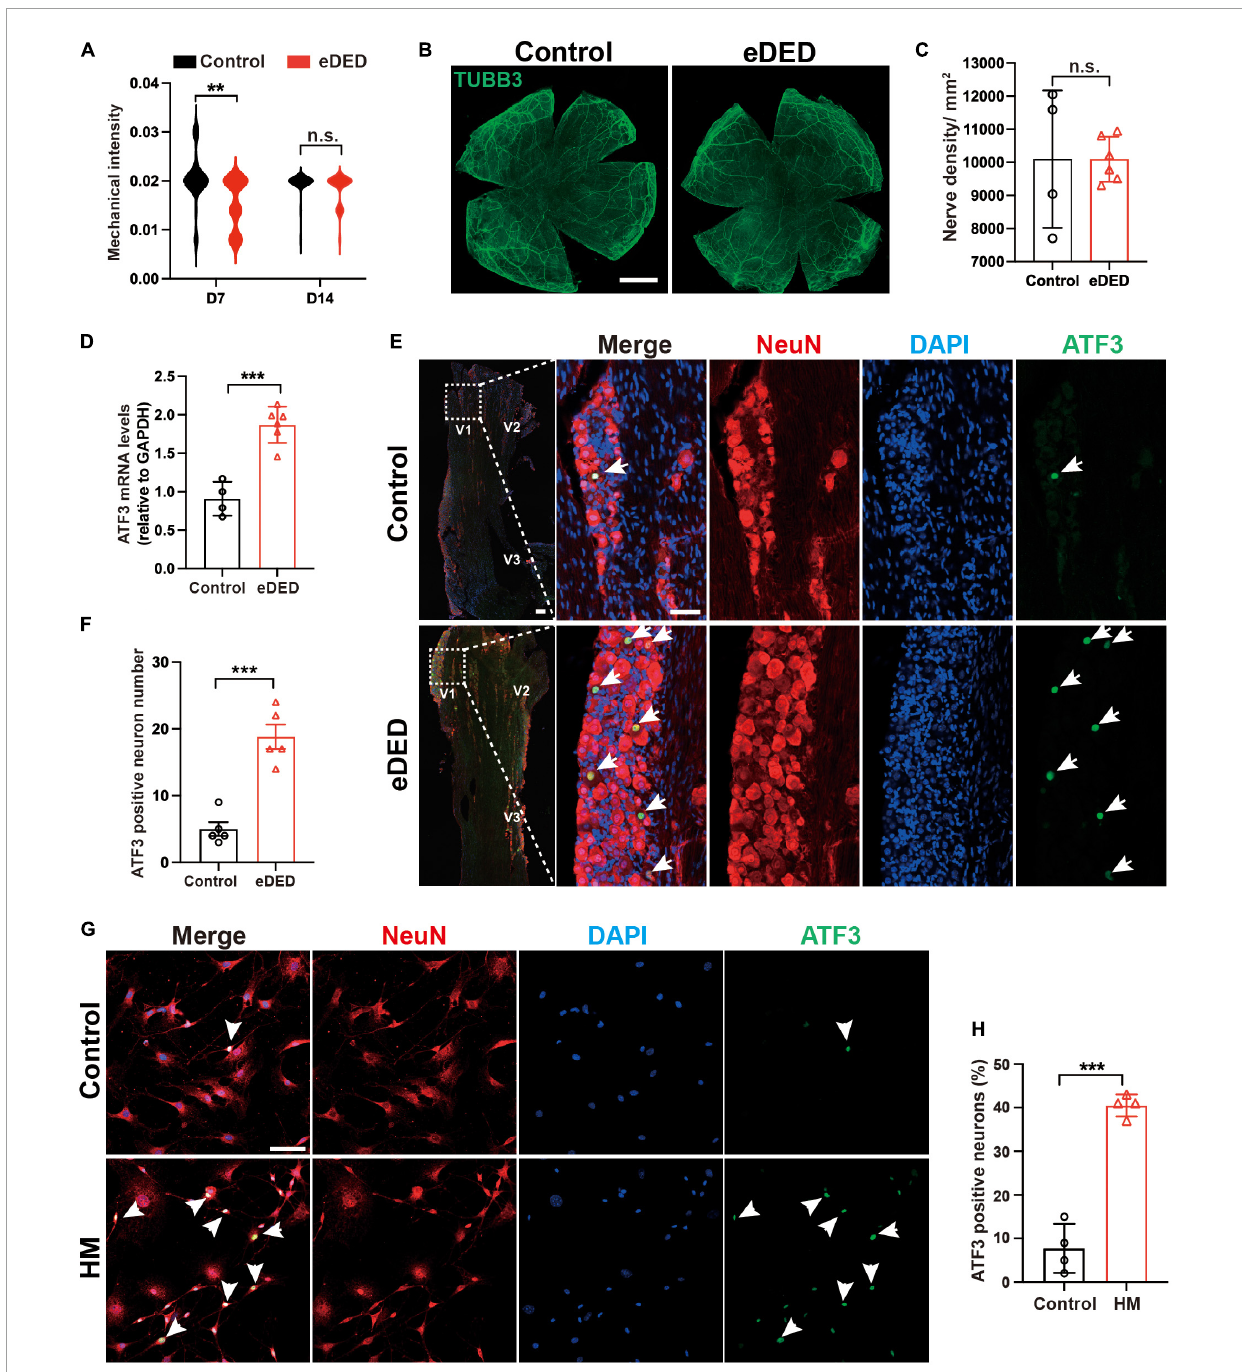
FIGURE2 Trigeminal ganglion (TG) corneal neuron injury in dry eye disease. (A) Violin graph showing corneal sensitivity via mechanical intensity in the control ( n = 22) and eDED ( n = 30), groups on day 7 and 14. (B) TUBB3 is a marker of neural cell body and fibers membrane. No significant change is seen in cornea nerve fibers (TUBB3, green) in the whole mount cornea of the control and eDED mice on day 14; scale bar: 1 mm. (C) Quantification of cornea nerve fiber density (count per mm 2 ) in control ( n = 4) and eDED ( n = 6) groups. (D) Quantification of TG ATF3 gene expression (relative to GAPDH mRNA) in control ( n = 4) and eDED ( n = 6), groups on day 14. (E) Increased TG neuron injury in the V1 part indicated by immunofluorescence staining in eDED mice on day 14. Co-localization of neuron injury marker ATF3 (expressed in nucleus, green, arrows), neuron marker NeuN (red) and DAPI (blue); scale bar, 50 µ m. (F) Quantification of ATF3-positive neurons in the control and eDED groups on day 14 ( n = 5 in each group). Y-axis represents the number of ATF3-positive neurons. Each dot represents the number of ATF3-positive neurons of one field of view (the magnification power of each field is 200) per TG slice. (G) Increased in vitro TG neurons injury indicated by immunofluorescence staining in HM group. Co-localization of neuron injury marker ATF3 (arrowheads), neuron marker NeuN and DAPI; scale bar, 50 µ m. (H) The proportion of ATF3-positive neurons of TG cell slices in the control and HM groups ( n = 4 in each group). Y-axis represents the proportion of ATF3-positive neurons. Each dot represents the mean ATF3-positive neurons proportion of three different fields of view (the magnification power of each field is 400) per cell culture dish. Data are represented as mean ± SEM; ** P < 0.01, *** P < 0.001; n.s., not significant. DED, dry eye disease; eDED, environmental dry eye disease; V1, ophthalmic branch; V2, maxillary branch; V3, mandible branch; HM, hyperosmotic medium; TG, trigeminal